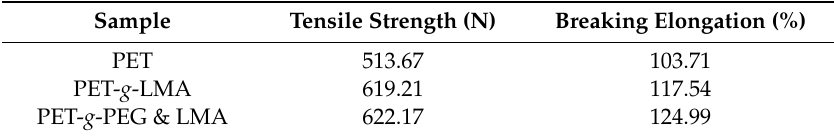
Table 1. The tensile properties of di ff erent PET fabrics.